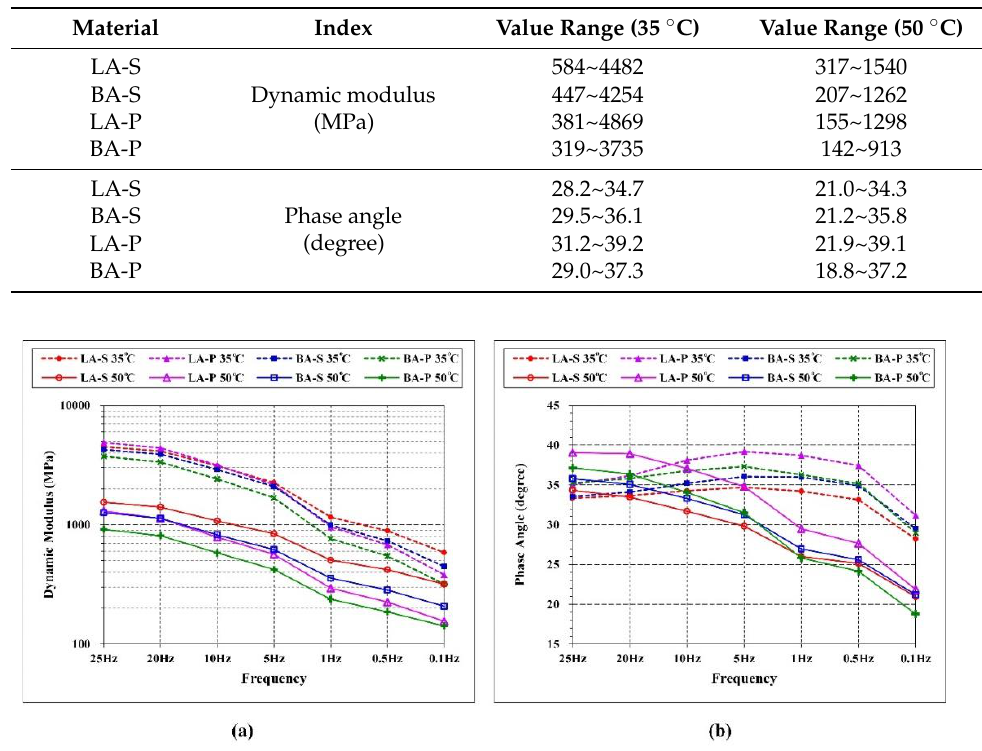
Table 6. The value range of DM and PA for the four mixtures at 35 ◦ C and 50 ◦ C.